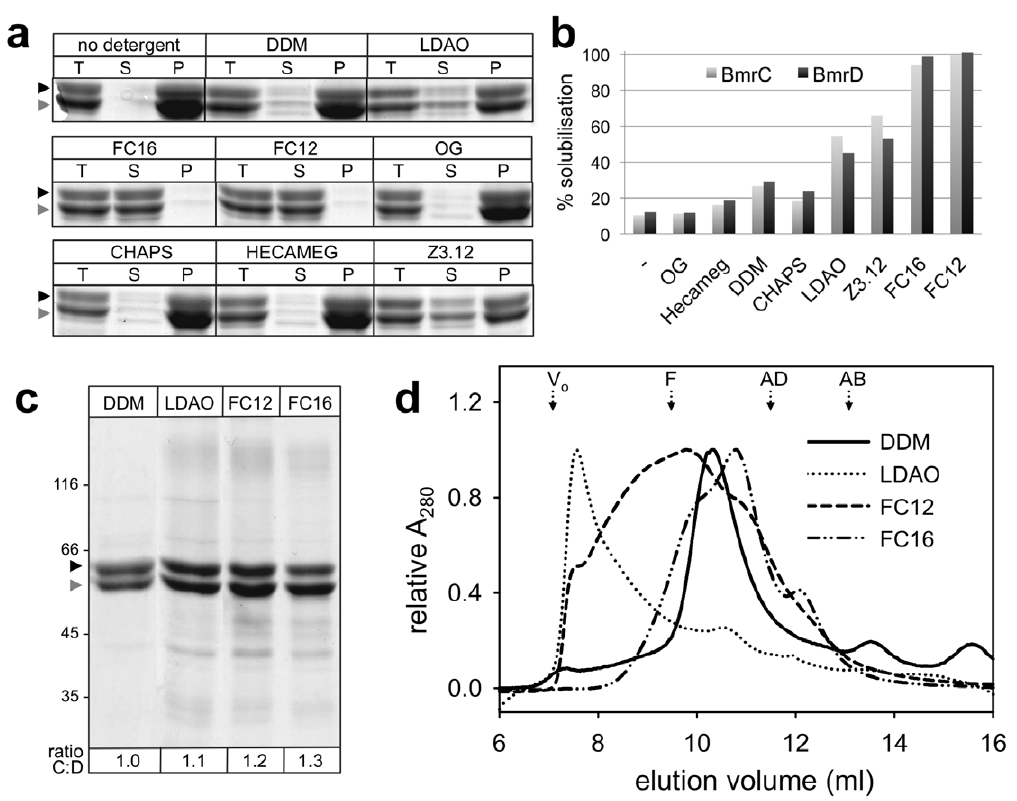
Figure 1. Purification of BmrC/BmrD using different detergents. ( a ) BmrC/BmrD solubilization by non-ionic and zwitterionic detergents was performed at 2 mg/ml protein and 10 mg/ml detergent and assessed by Coomassie Blue stained SDS-PAGE of the soluble (S) and insoluble (P) material obtained from 15 m g of total protein sample (T). Note that the strong densities observed in some of the pellet bands probably arise from difficulties encountered while resuspending the pellet that led to inhomogeneous samples. Black arrowhead, BmrD; grey arrowhead, BmrC. ( b ) The intensities of the bands corresponding to the S and T samples were quantitated using Image Gauge software (Fuji Film Science Lab) and the solubilization yields were calculated as the ratio of each protein in the supernatant (S) relative to its amount in the membrane fraction (T). ( c , d ) Protein purified by nickel affinity chromatography in the presence of the indicated detergents was analyzed by ( c ) Coomassie Blue stained SDS-PAGE (5 m g per lane, except for DDM : 4 m g) and ( d ) size-exclusion chromatography performed on a Superdex 200 10/300 GL column using 0.05% (w/v) DDM in the elution buffer. Elution volumes of proteins used for column calibration are indicated above: ferritin (F, 440 kDa), aldolase (AD, 158 kDa), albumin (AB, 67 kDa), V o : void volume. The intensities of the BmrC and BmrD bands in the polyacrylamide gel in c were quantitated and the ratio BmrC:BmrD (ratio C:D) was indicated under each lane. Black arrowhead, BmrD; grey arrowhead, BmrC.